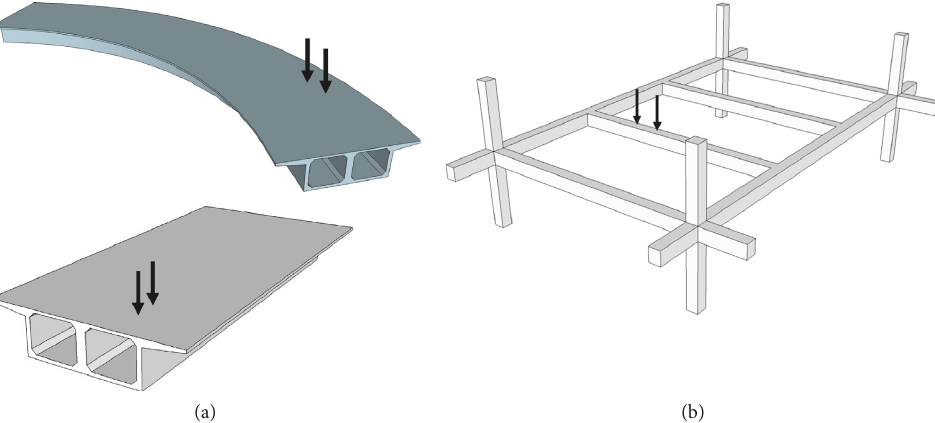
Figure 1: Various reinforced concrete structures subjected to torsion. (a) Equilibrium torsion of eccentrically loaded box girders and (b) compatibility torsion of spandrel beams.